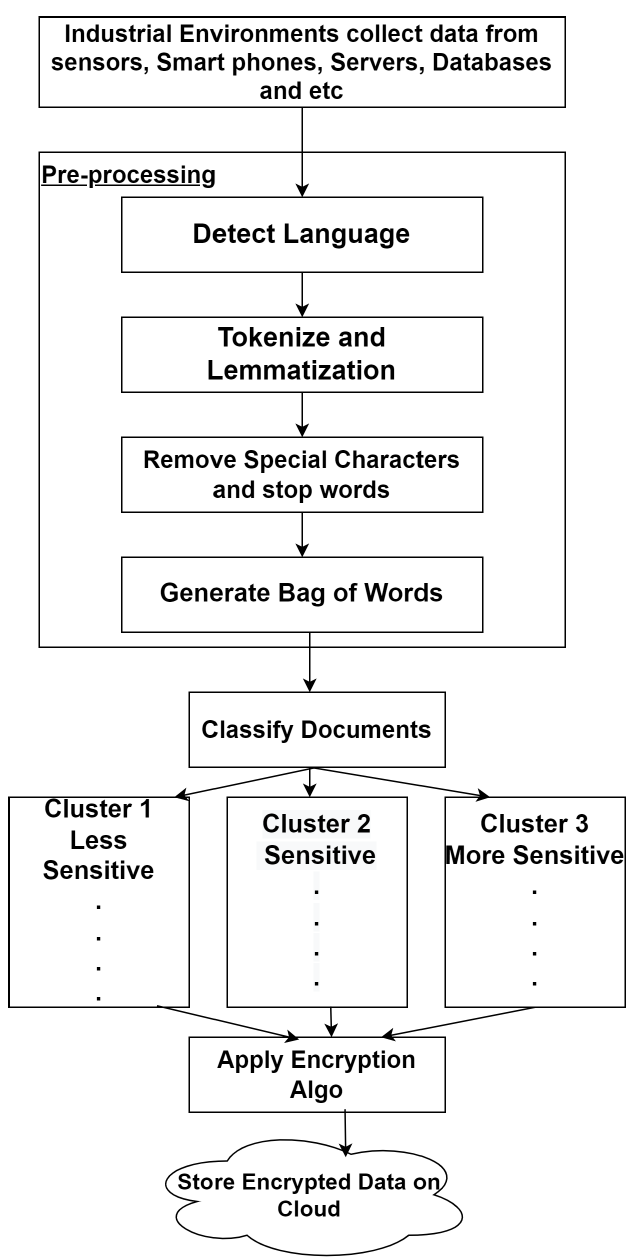
Figure 5. Document Segregation